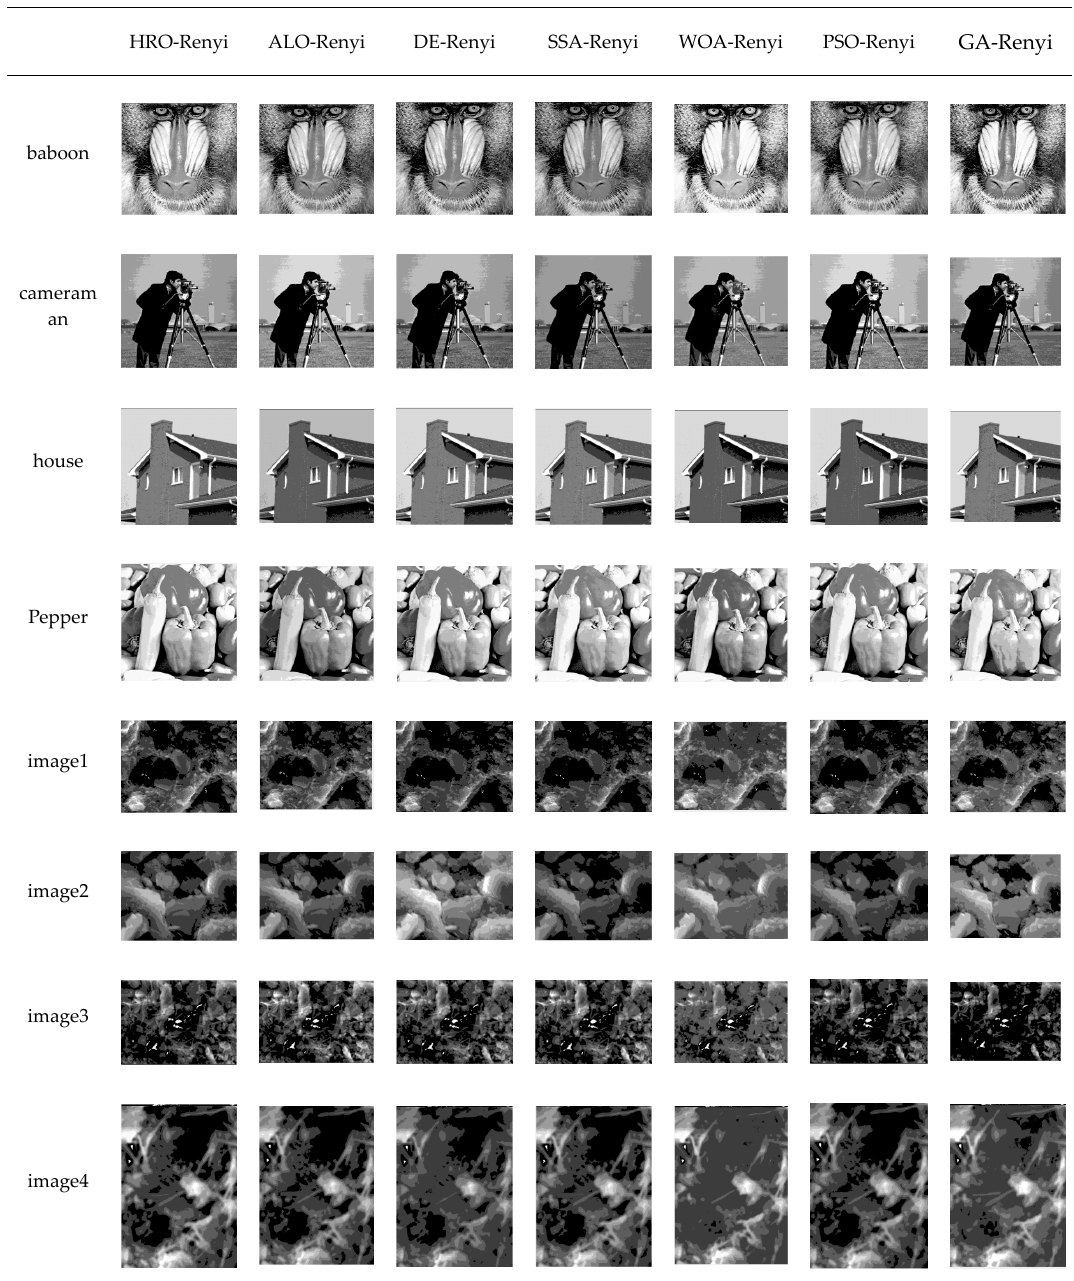
Figure 6. Segmented image obtained from the methods of HRO-Renyi, DE-Renyi, PSO-Renyi, SSA-Renyi, ALO-Renyi, WOA-Renyi,